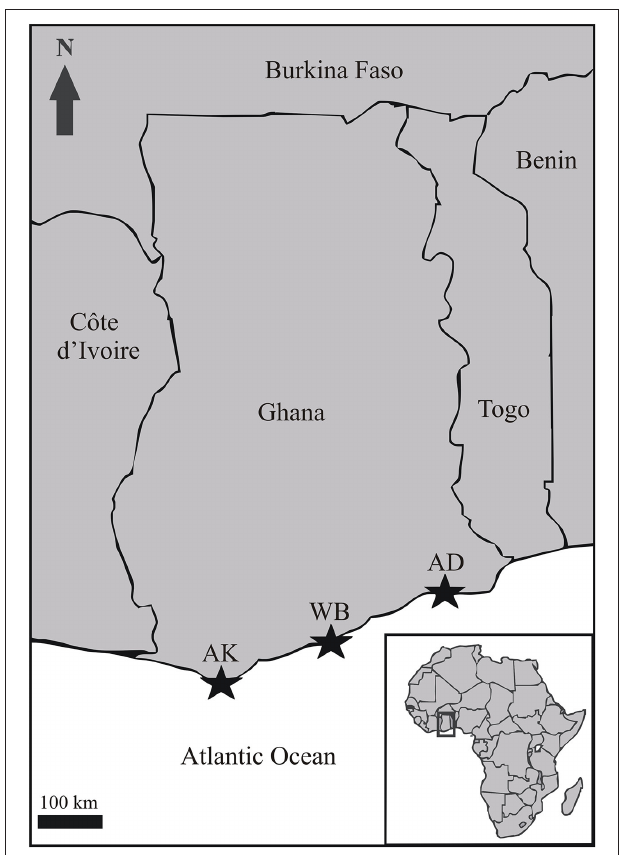
FIGURE 1 | Surveys were conducted in Akwidaa, Winneba, and two villages (Azizenya and Totope) on the Ada peninsula in Ghana, West Africa. AK, Akwidaa; WB, Winneba; AD,